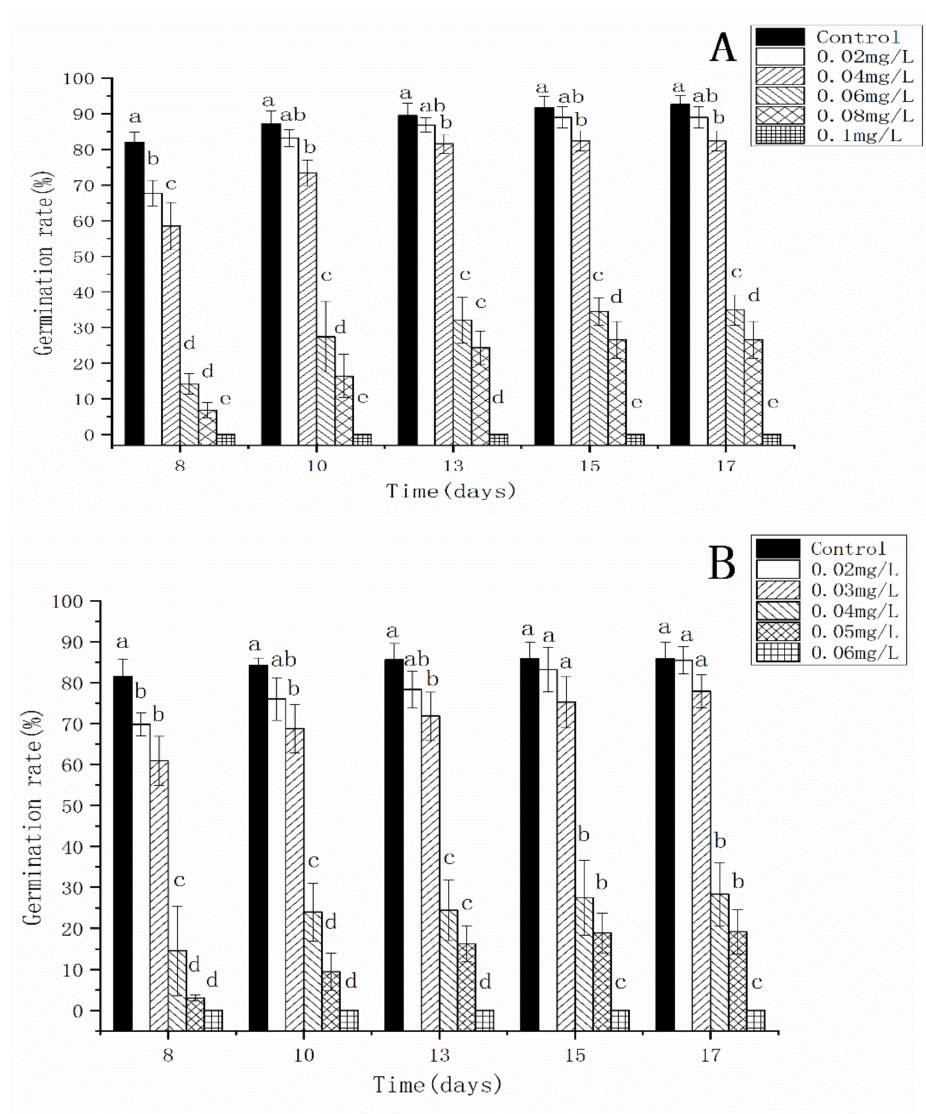
Figure 4. Effect of AgNPs ( A ) and Ag + ( B ) on the spore germination of Ceratopteris thalictroides . Data represent the mean ± SD ( n = 5). Data with different letters are significantly different ( p <